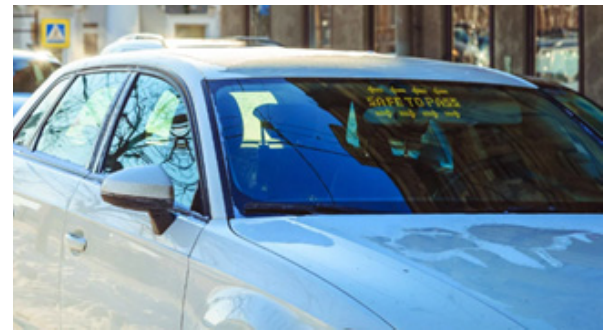
Figure 4. In-glass display concept.